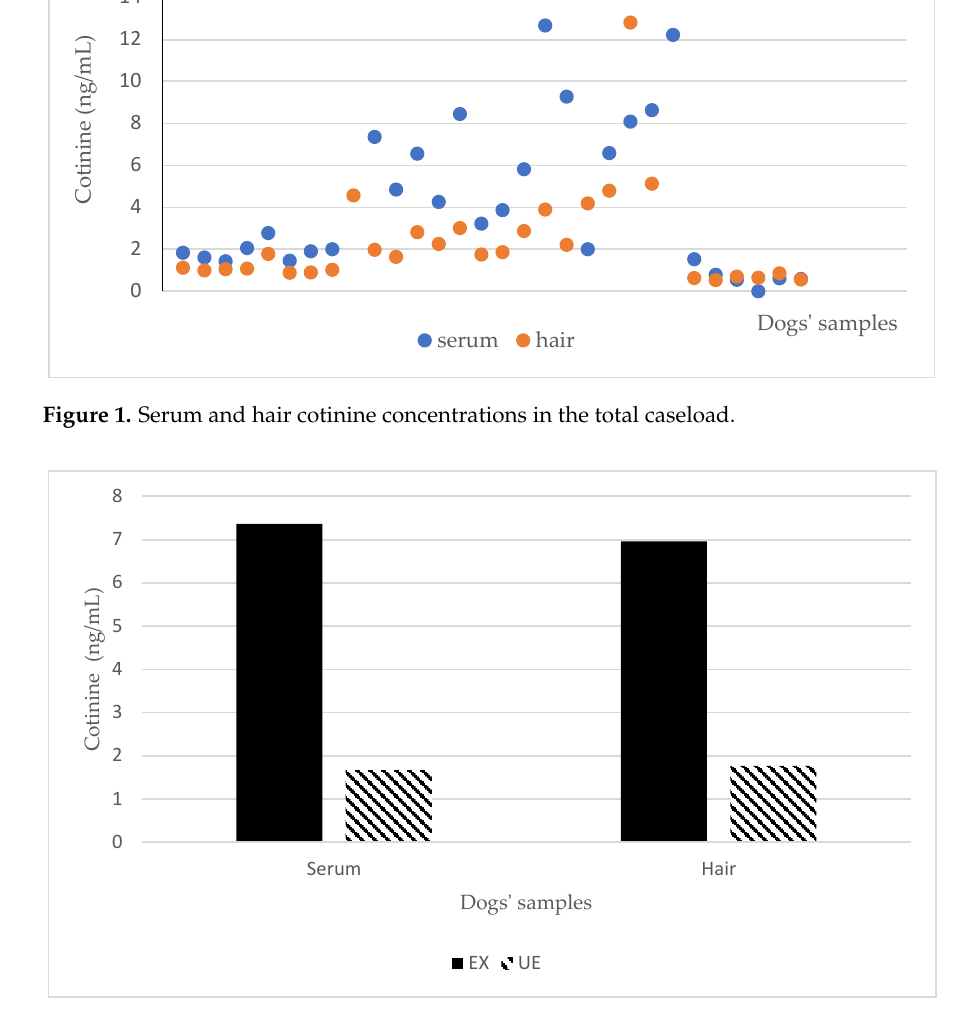
Figure 2. Serum and hair cotinine concentrations in exposed and unexposed dogs. EX means dogs that were exposed to the owner’s tobacco smoke; UE means dogs that were unexposed to the owner’s tobacco smoke .